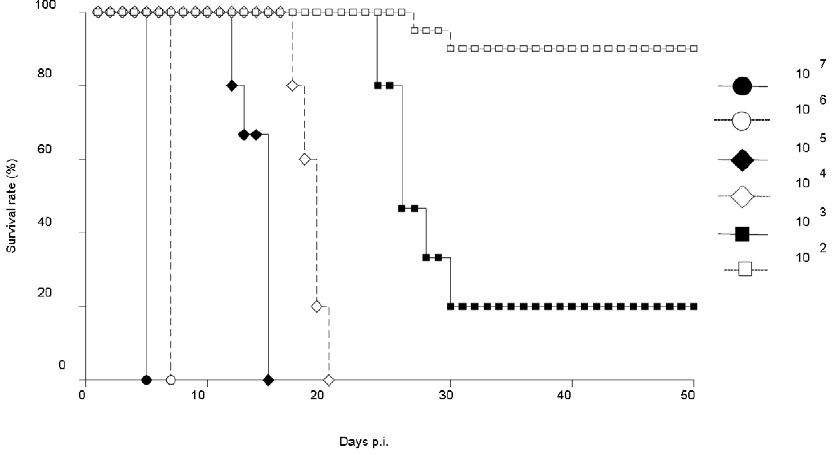
Figure 1. Survival rates in AG129 mice infected with a dose range of D2Y98P virus. AG129 mice were infected intraperitoneally (ip.) with 10-fold serially diluted viral doses of D2Y98P ranging from 10 7 to 10 2 PFU. Ten mice per group were used. Data are representative of at least 3 independent experiments.